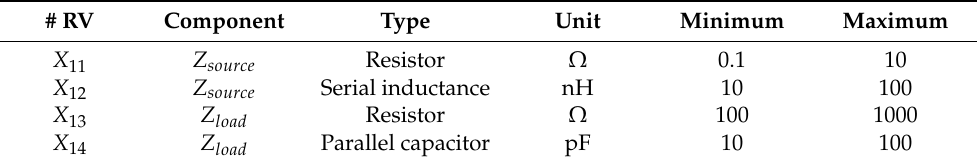
Table 3. UQ with RVs Uniformly distributed involved for test case #2, in addition to RVs X 1 to X 10 in Tables 1 and 2 (Channels #1 and